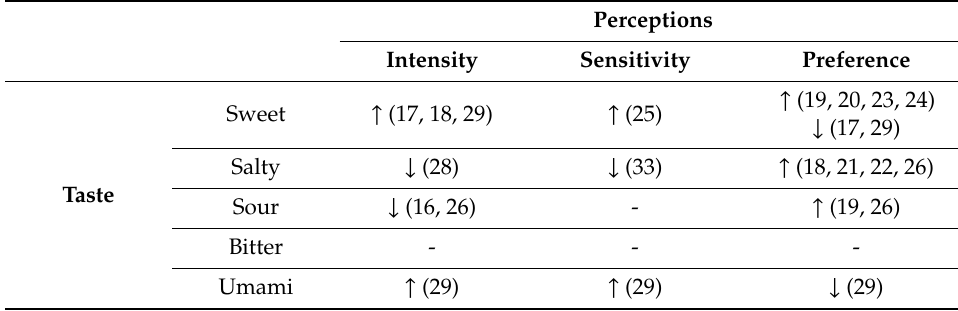
Table 4. Impact of acute and chronic physical exercise on taste